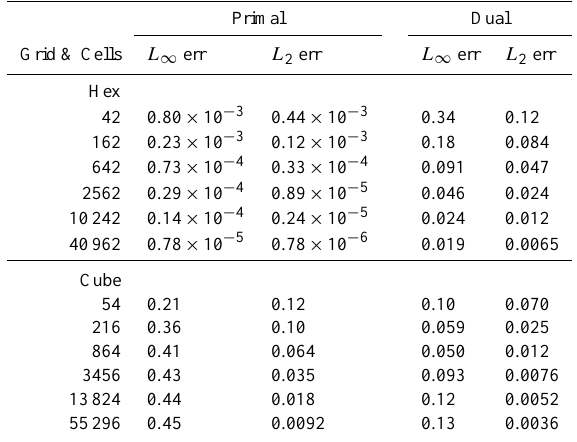
Table 4. Convergence of the primal and dual grid scalar Laplacians. Primal